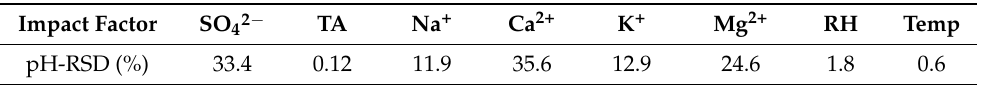
Table 1. Sensitivity of PM 1 pH to SO 42 − , TA (NH 3 + NH 4+ ), Na + , Ca 2+ , K + , Mg 2+ , RH, and temperature. The larger the relative standard deviation (RSD) was, the greater the impact the variable had on